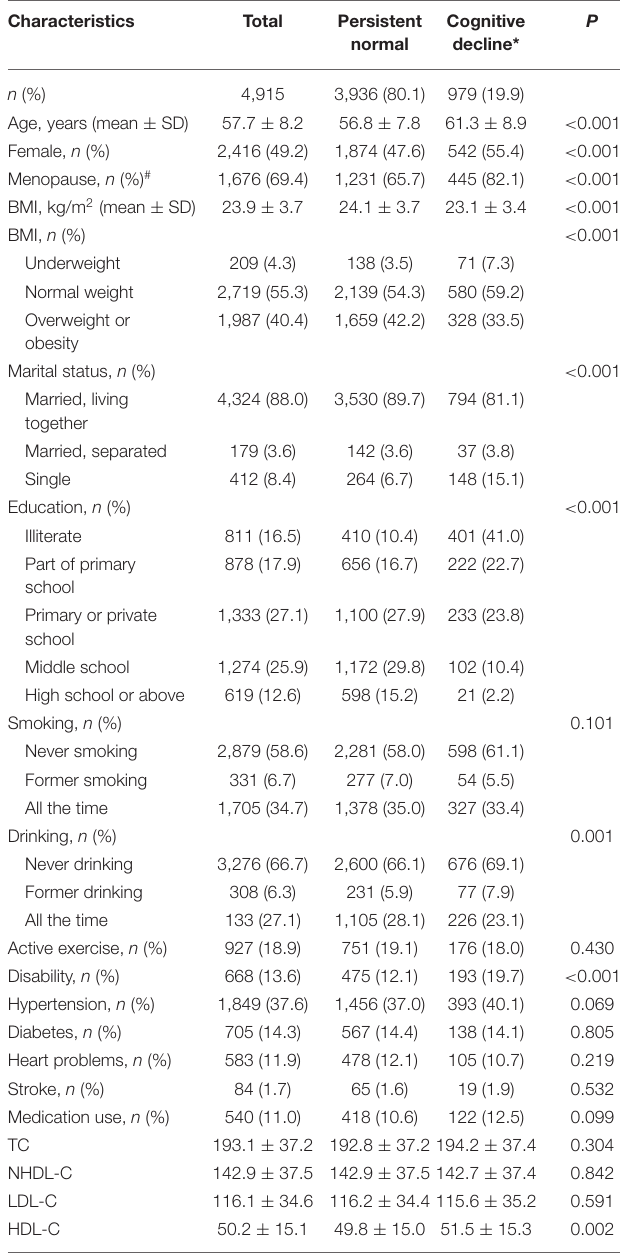
TABLE 1 | Baseline characteristics of participants with or without cognitive decline from 2011 to